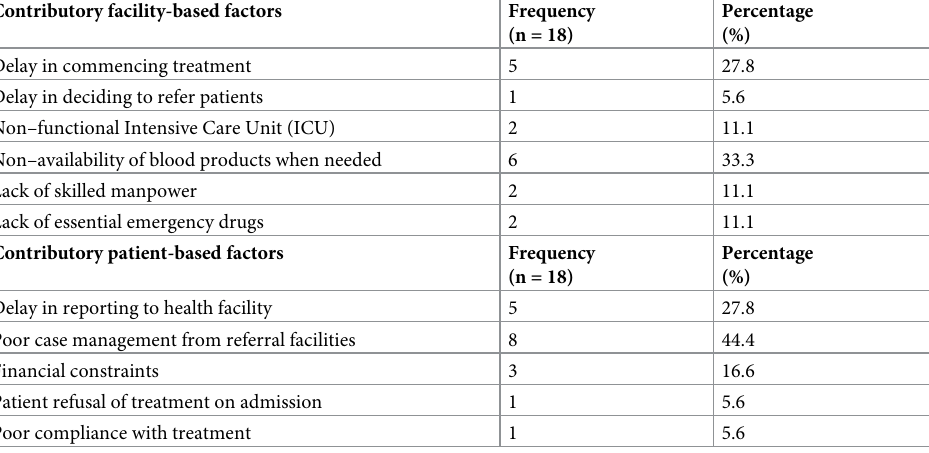
Table 3. Contributory factors to Maternal Deaths in Central Hospital, Benin City from October 2017 to May